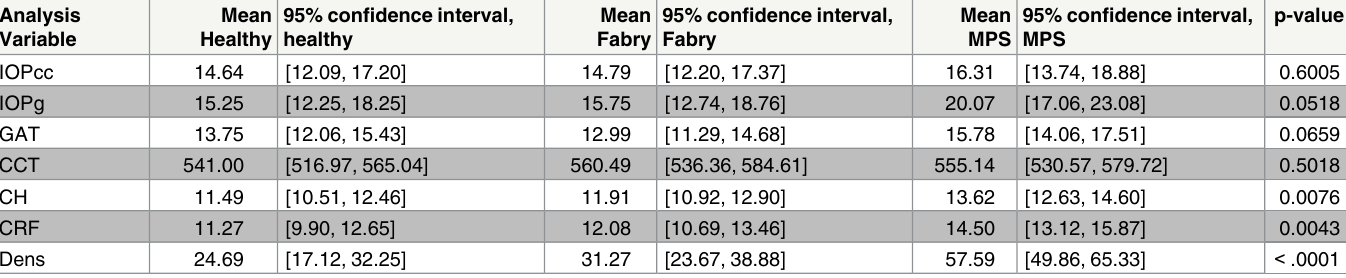
Table 3. Mean (estimated from linear mixed effectsmodel) and corresponding 95% confidence interval of Goldmann applanation tonometry (GAT), corneal compensated intraocular pressure(IOPcc), Goldmann-correlated intraocular pressure(IOPg), central corneal thickness (CCT), cor- neal hysteresis (CH), corneal resistancefactor (CRF) and corneal density. Analysis